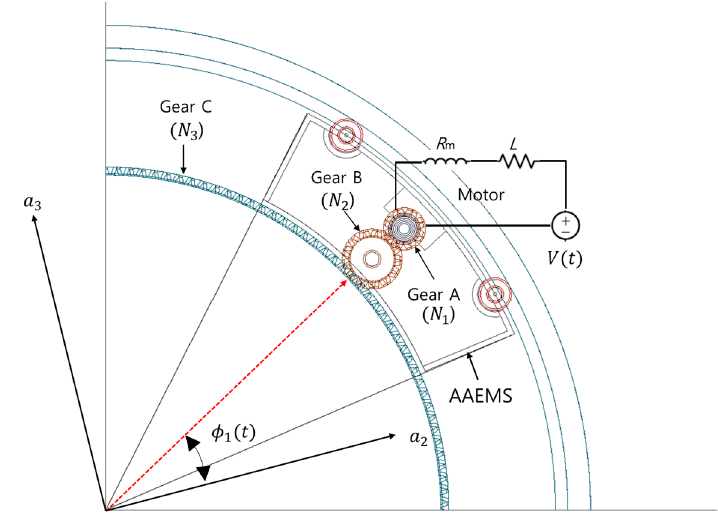
Figure A1. re-captured image of AAEMS from Figure 1.